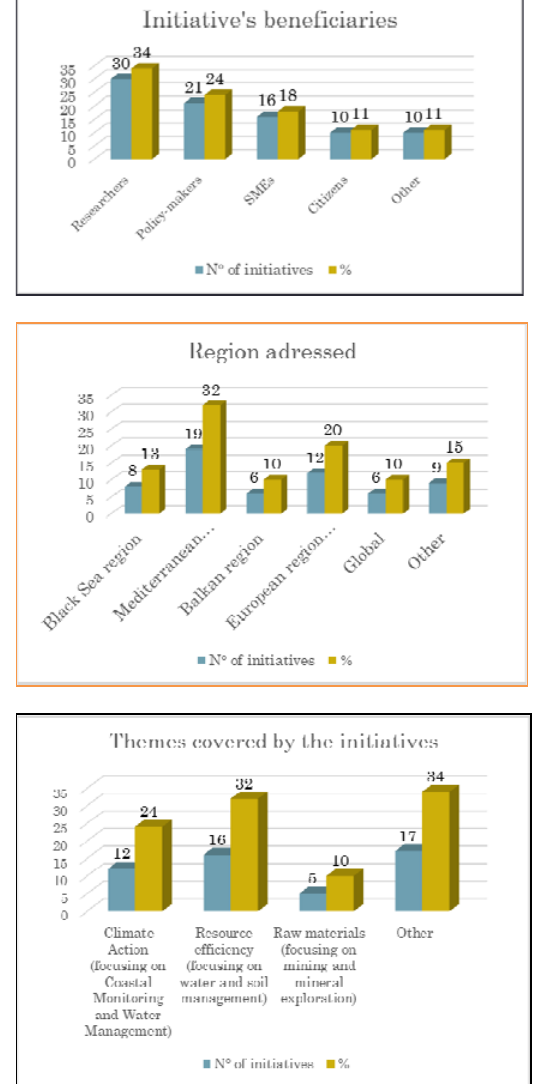
Figure 3. 21 initiatives that produce datasets and/or web- services